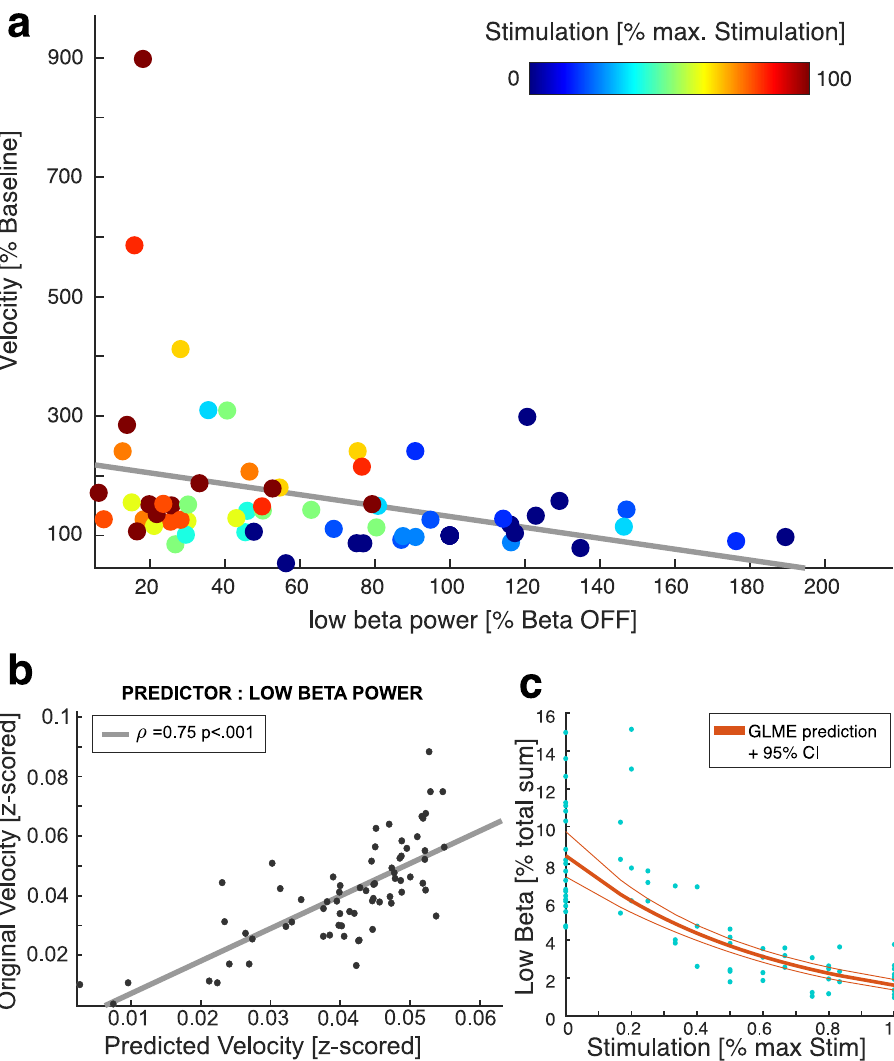
Fig. 4 Suppression of low-beta activity corresponds with motor improvement. a Scatter plot summarizing interrelation between motor performance, beta suppression and stimulation intensity for the patient cohort, stimulation is presented in % of maximal stimulation, which was the maximum tolerable intensity. b Linear mixed effects model shows that low-beta-band activity is a strong predictor for velocity improvement, while the relationship between stimulation intensity and beta suppression follows a logarithmic relation ( c as predictor for movement velocity (LME with low-beta power: BIC − 393.35, LME with high-beta power: BIC − 380.57, Δ BIC > 6 = strong evidence for superiority). The LME model also revealed alpha to be predictive for bradykinesia, (Coef fi cient Estimate: − 0.002, P =